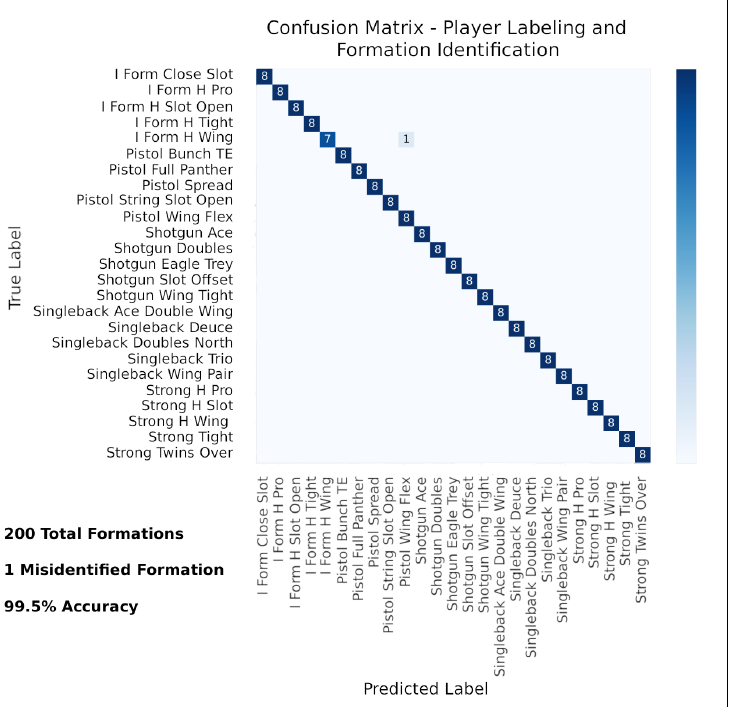
Figure 21. Confusion matrix of player labeling and formation identification modules—out of the 200 images used for testing the combined player labeling and formation identification modules, 1 image was misidentified, giving a 99.5%